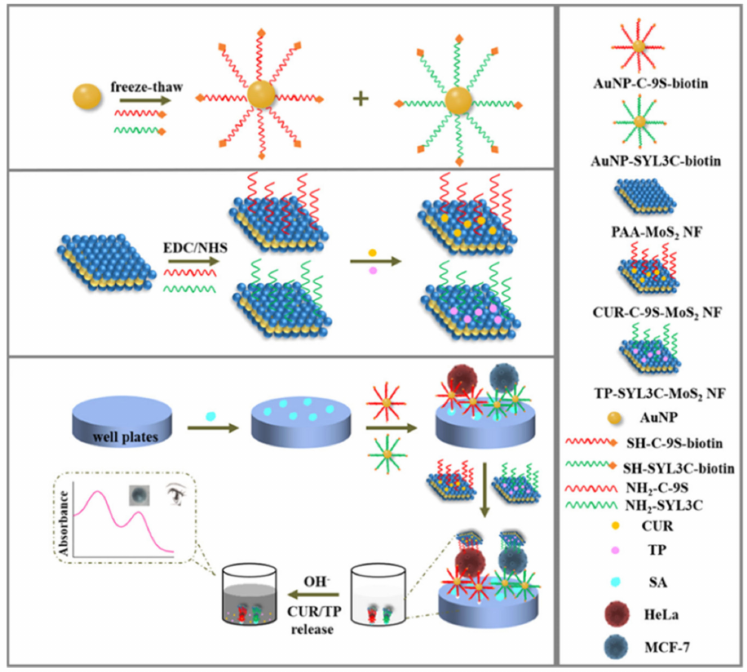
Figure 4. Illustration of pH-responsive nanotags-based nanobioplatform for the efficient capture and colorimetric detection of heterogeneous CTCs [96]. Copyright 2021 American Chemical